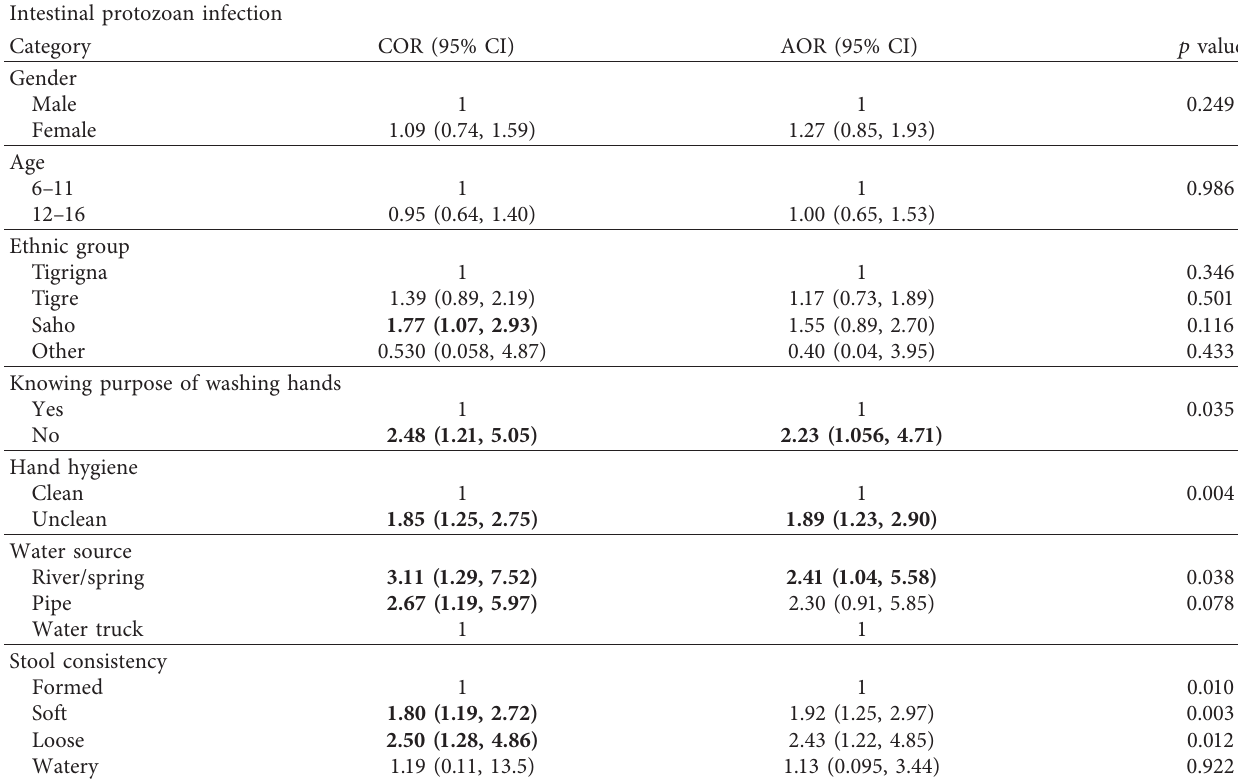
Table 6: Multivariate logistic regression analysis showing predictors of intestinal protozoan infection among school children, n � 450. Intestinal protozoan infection